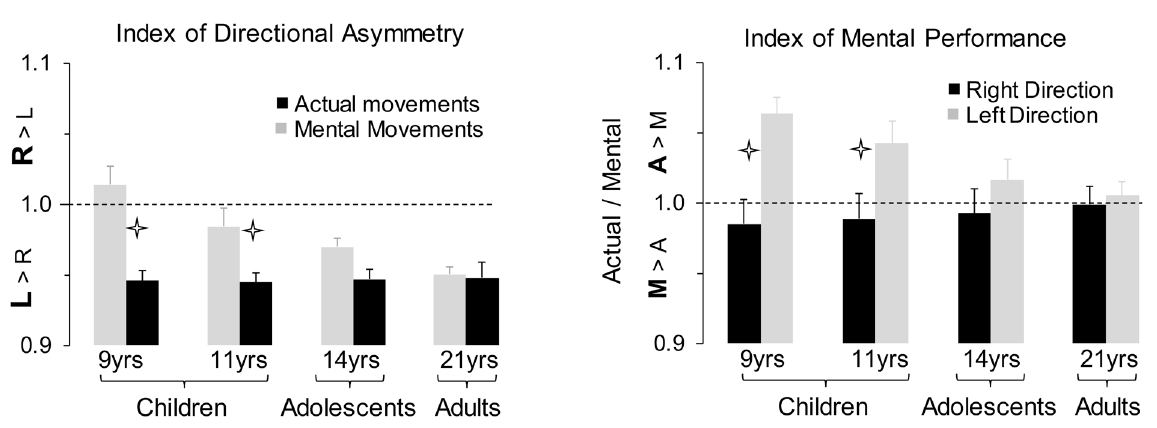
Figure 3. Average values ( + SE) of the index of directional asymmetry (R/L) for the four age-groups. Stars indicate significant differences between actual and mental movements. doi:10.1371/journal.pone.0073042.g003 PLOS ONE |